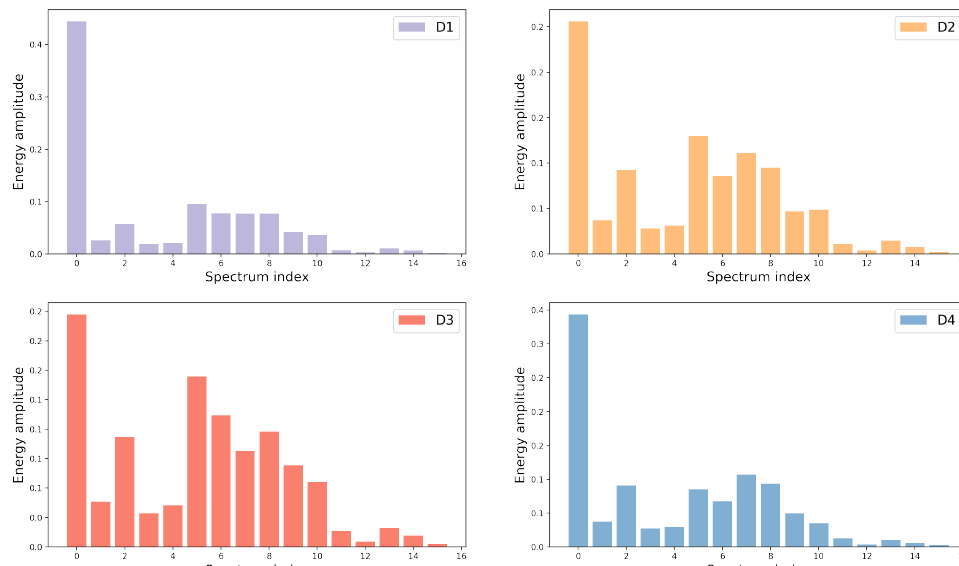
Figure 2. The feature vectors obtained by wavelet packet decomposition under the different damage cases. The 4 damage case are represented by D1–D4.